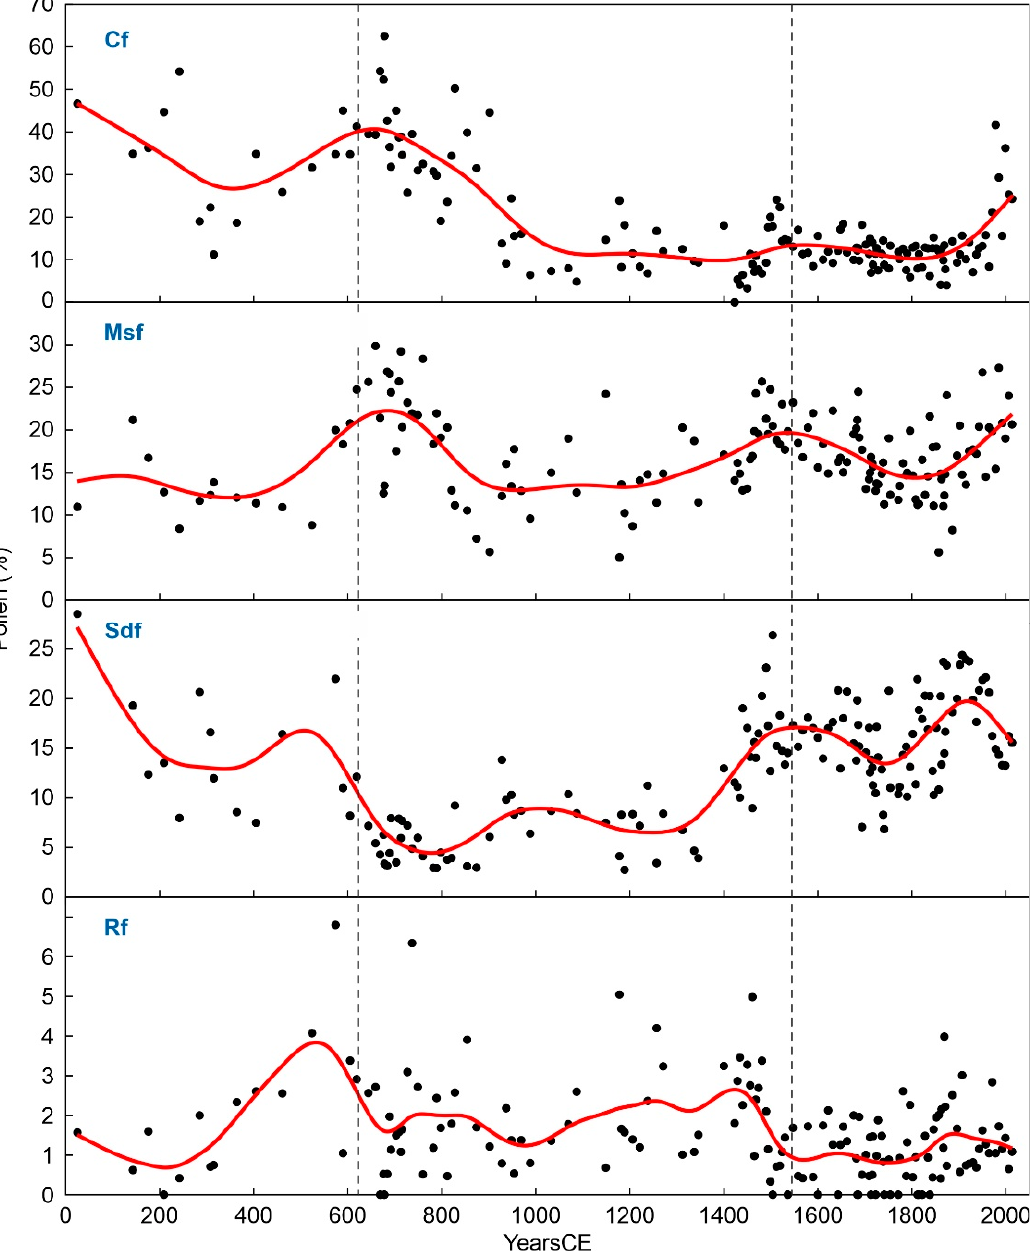
Figure 6. Forest pollen groups considering the forest types defined with the cluster analysis (Figure 5), which coincide with present-day forest associations. Black dots: raw data, red line: smoothing spline. Conifer forest (Cf): Pinus ; Mediterranean sclerophyll forest (Msf): evergreen Quercus ; Submontane deciduous forest (Sdf): deciduous Quercus , Betula , Fagus and Corylus ; Riverine forest: Alnus , Salix and Ulmus .